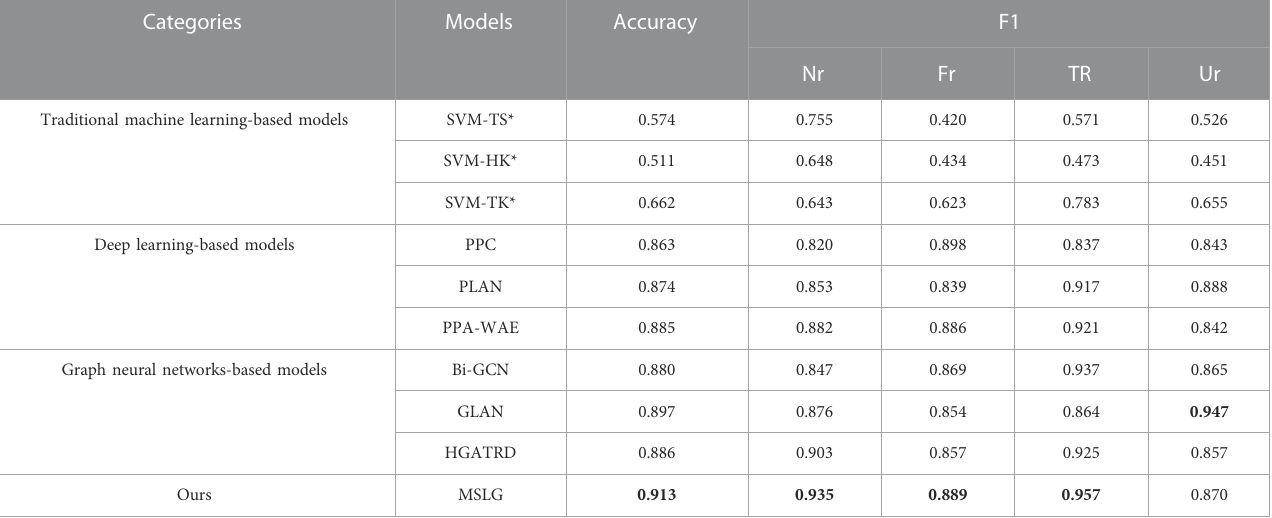
TABLE 4 Performance on Twitter16 dataset. The results indicated with * are obtained from [14] (NR: Non-Rumor; FR: False Rumor; TR: True Rumor; UR: Unveri fi ed Rumor). Categories Models Accuracy F1